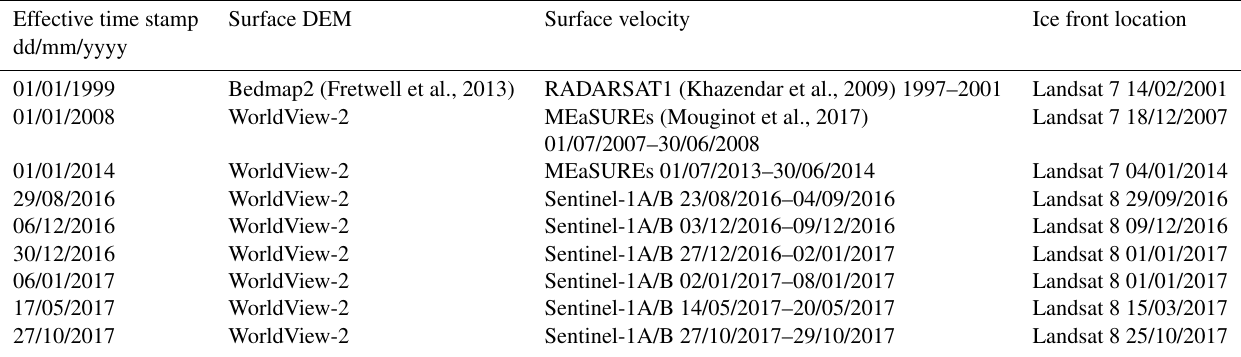
Table 1. Data sources and corresponding timestamps used for the stress calculations. The effective timestamp in the first column corresponds to the middle of the velocity feature tracking window, and WorldView-2 surface elevations were shifted to the corresponding effective time